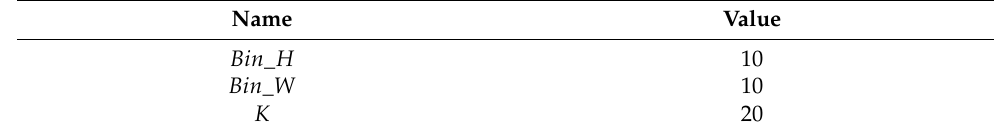
Table 2. Experimental conditions for the benchmark problem.